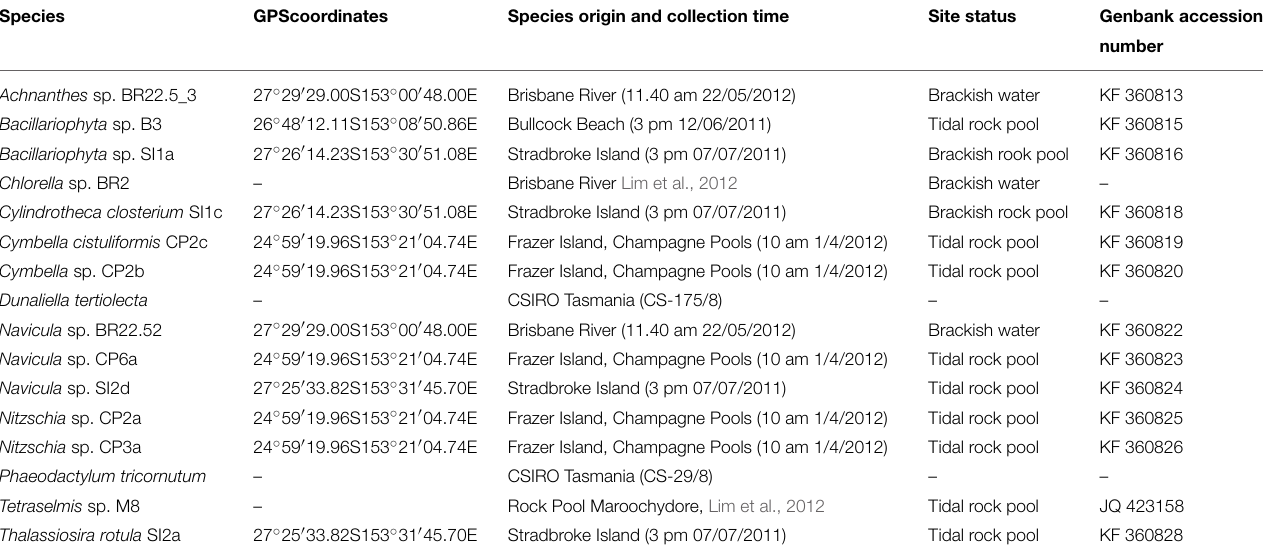
TABLE 1 | Sources and accessions of microalgae used in this study.